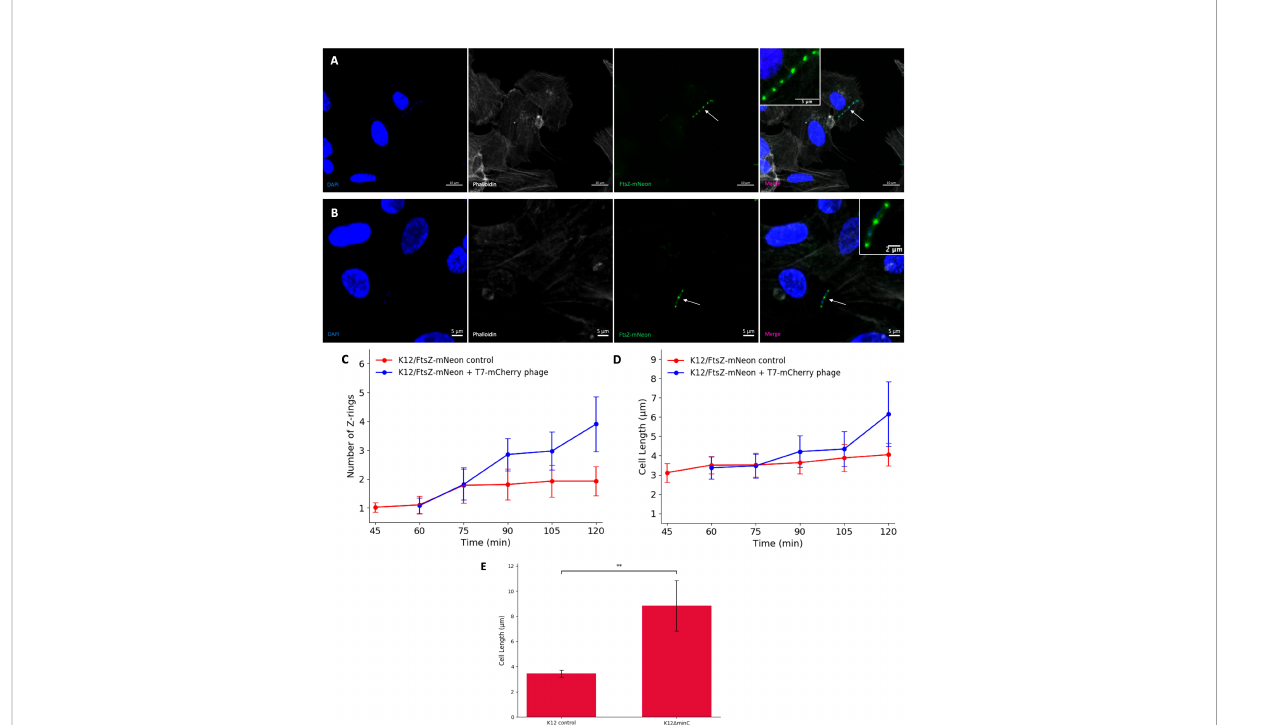
FIGURE 3 T7 phage inhibition of FtsZ in K12 Escherichia coli cells. (A, B) Fluorescent images of K12/FtsZ-mNeon cells after T7-mCherry phage infection fi xed in a human cell model. Arrows point to fi lamentous cells. DAPI stain is shown in blue, phalloidin in grey, and FtsZ-mNeon in green. (C, D) Quanti fi cation of Z-ring number and cell length for 75 K12/FtsZ-mNeon bacterial cells infected with T7-mCherry phage at 15-min intervals and compared to a no-phage control. Averages plotted with error bars showing one standard deviation of uncertainty. (E) Quanti fi cation of cell length for 75 K12 control and K12 D minC bacterial cells. Tukey ’ s tests were performed, and the calculated probability values (p-values) are displayed as p < 0.01